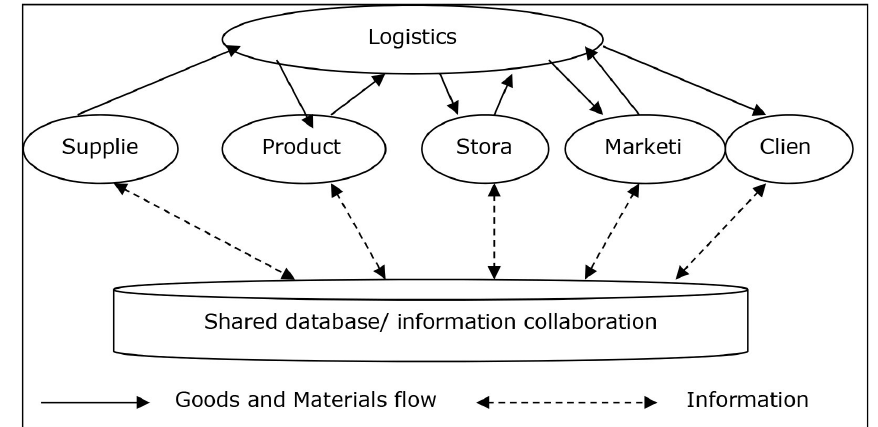
Figure 3. A decomposition map of collaborative management of supply